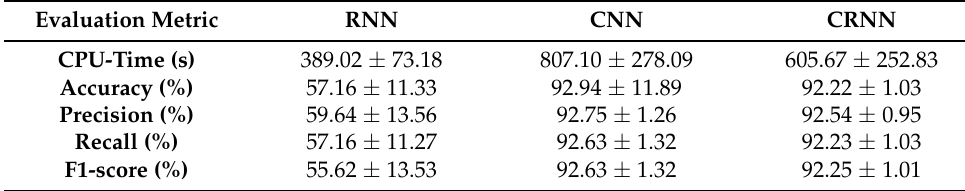
Table 13. Identification results